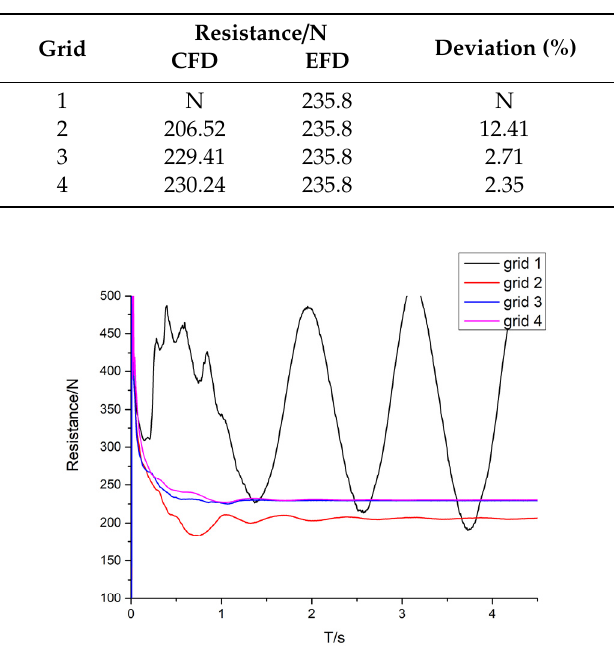
Figure 9. The resistance curve of different grids.